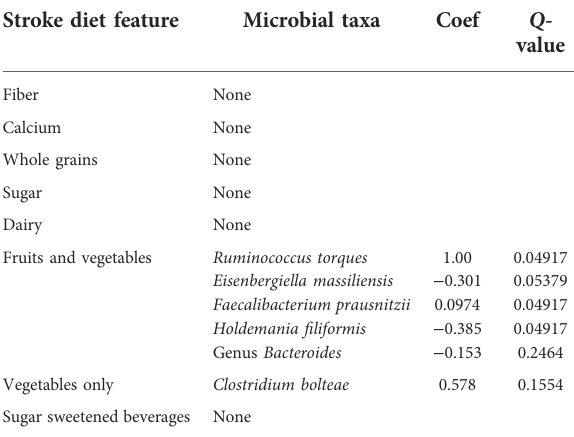
TABLE 3 Microbial taxa associated with diet in stroke